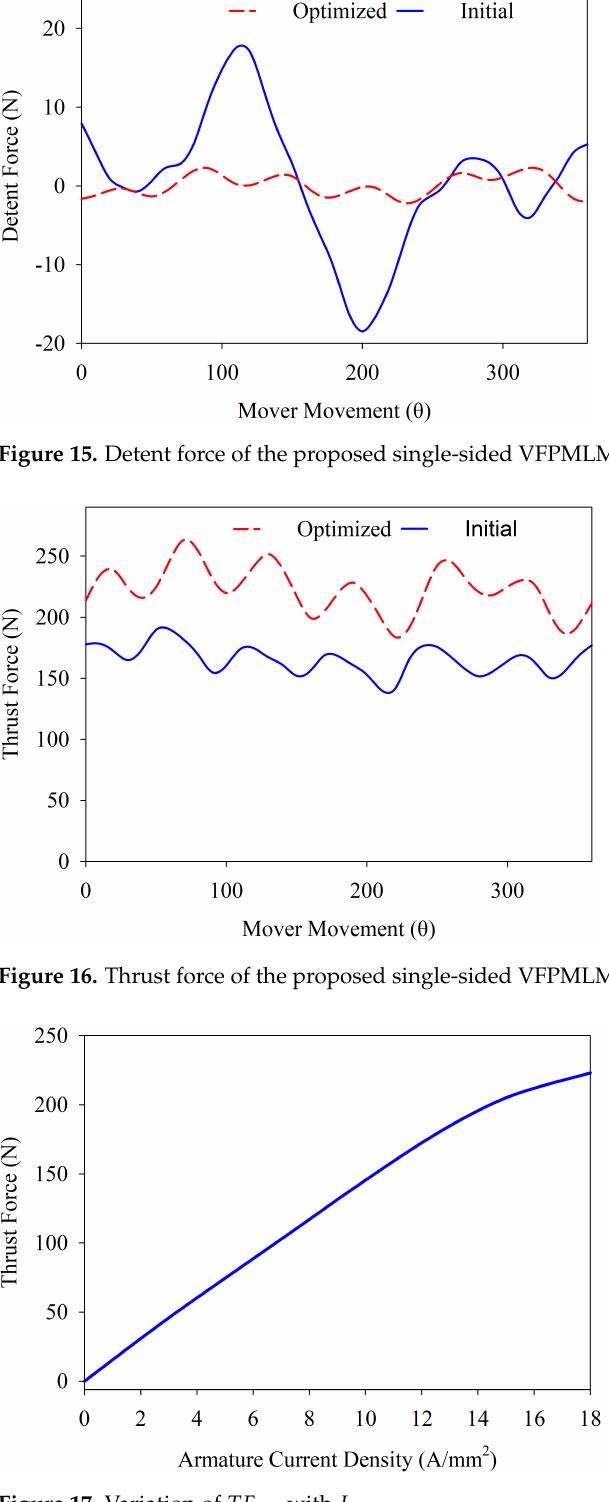
Figure 17. Variation of TF avg with J AC